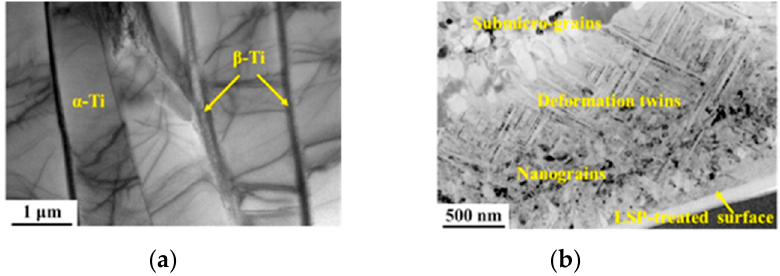
Figure 13. Transmission Electron Microscopy (TEM) image of ( a ) EBM as-built specimens, and ( b ) Laser Shock Peening (LSP)-treated specimens. Adapted from [113], with permission of Elsevier, 2020. Eyzat et al. [115] studied the effect of distinct post-treatments on the mechanical properties,